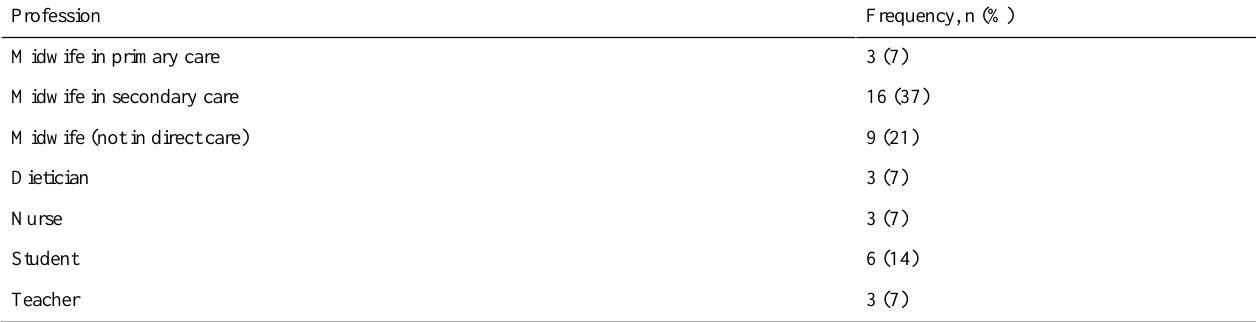
Table 2. Professions of health care providers participating in answering two open questions